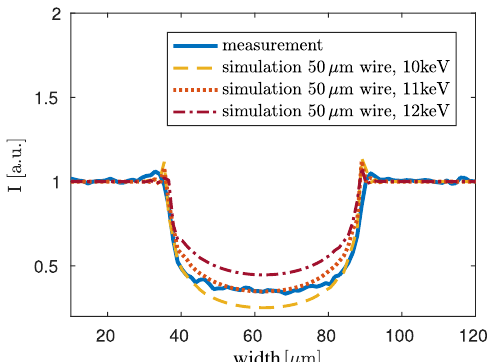
Figure 6. Monochromatic simulations of the propagation signature of a 50 µ m titanium wire for different energies. Source-blurring is neglected in the simulations. A lineplot of the measurement shown in Figure 2 is plotted in blue for comparative reasons. In yellow the simulation for 10keV, in orange the simulation for 11keV and in red the simulation for 12keV is shown. The simulation in orange for 11keV yields the best fit for the measured values at the centre of the